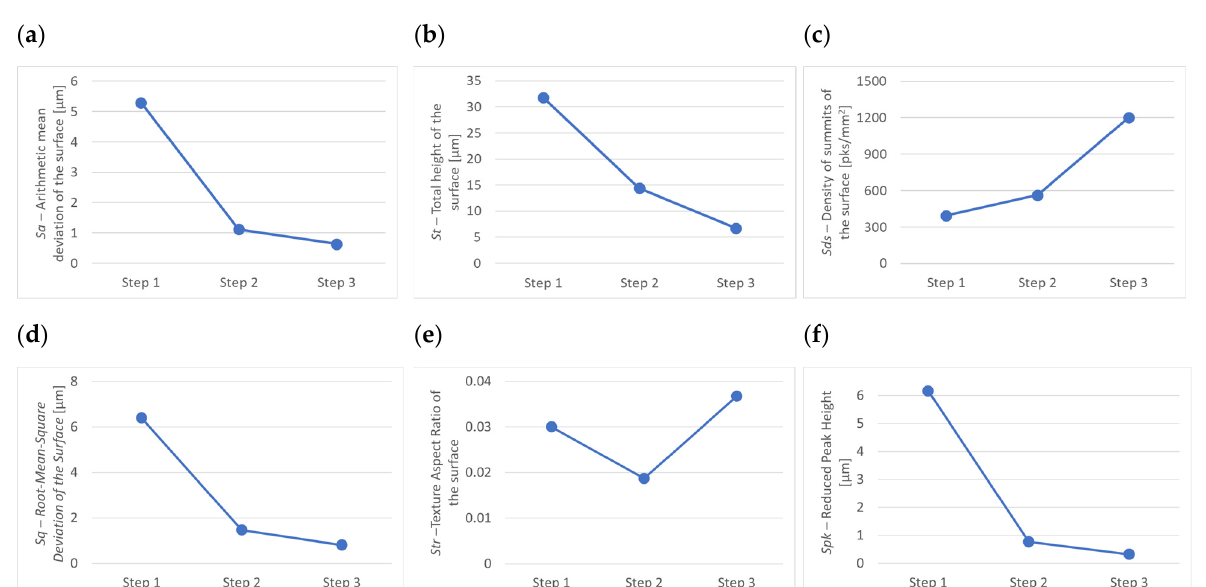
Figure 14. Analysis of the Abbo tt -Fireston load-curve of machined surfaces: ( a ) after shape milling; ( b ) after shape milling and coarse grinding; ( c ) after shape milling, coarse grinding and fi nish grind- ing.